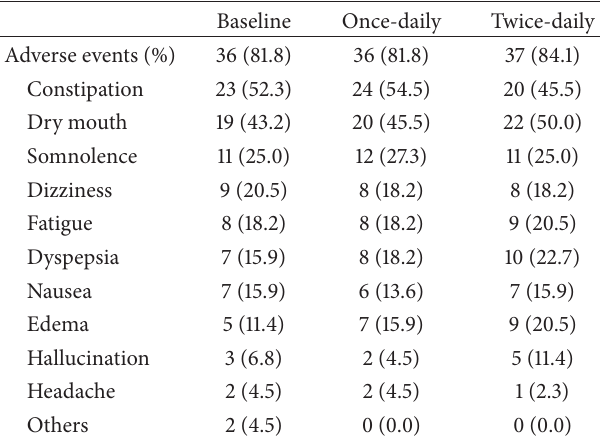
Table 4: Adverse